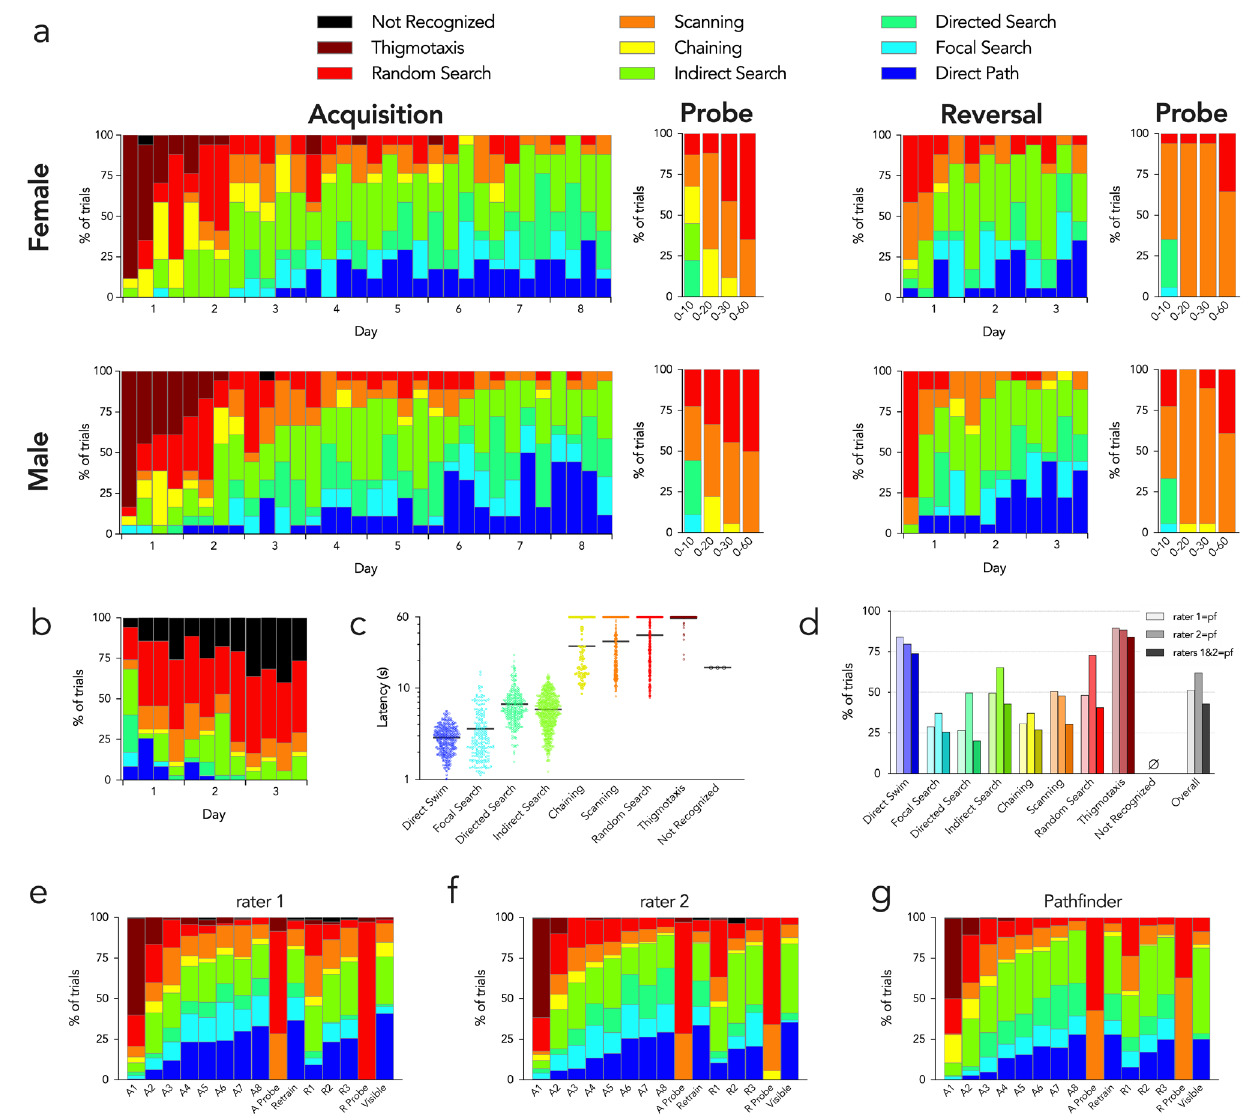
Figure 4. Pathfinder search strategy categorization of water maze performance. a ) Search strategies for male and female mice. Each set of stacked bars indicates strategies used for the 4 acquisition and reversal trials for each day. Probe strategies are shown for the entire trial (0–60s) and for the first 10, 20 and 30s. b ) Reversal strategies relative to the original platform location (indirect search excluded from analyses, since short swims that bypass the old location but quickly go to the new location become incorrectly classified as indirect searches with current settings). c ) Escape latencies for all 1888 trials varied by strategy. Symbols indicate individual trials, bars indicate means (Kruskal Wallis test, P<0.0001; Dunn’s tests: direct path vs all others except focal search, P<0.0001; focal search vs all others except direct path, P<0.0001; directed search vs all others except indirect search, P<0.0001; indirect search vs all others except directed search, P<0.0001; chaining vs all others except scanning and random, P<0.01; scanning vs all others except chaining and thigmotaxis, P<0.01; random vs all others except chaining, P<0.05; thigmotaxis vs all others except random search, P<0.05). d ) Manual vs automatic categorization. For each strategy assigned by Pathfinder, the proportion that received the same classification (manually) by 2 raters is shown. “Raters 1+2” indicates the percentage of Pathfinder classified-trials that also received the same classification by both raters. e ) Search strategy classification by rater 1 for each day of testing. f ) Search strategy classification by rater 2 for each day of testing. g ) Search strategy classification by Pathfinder for each day of